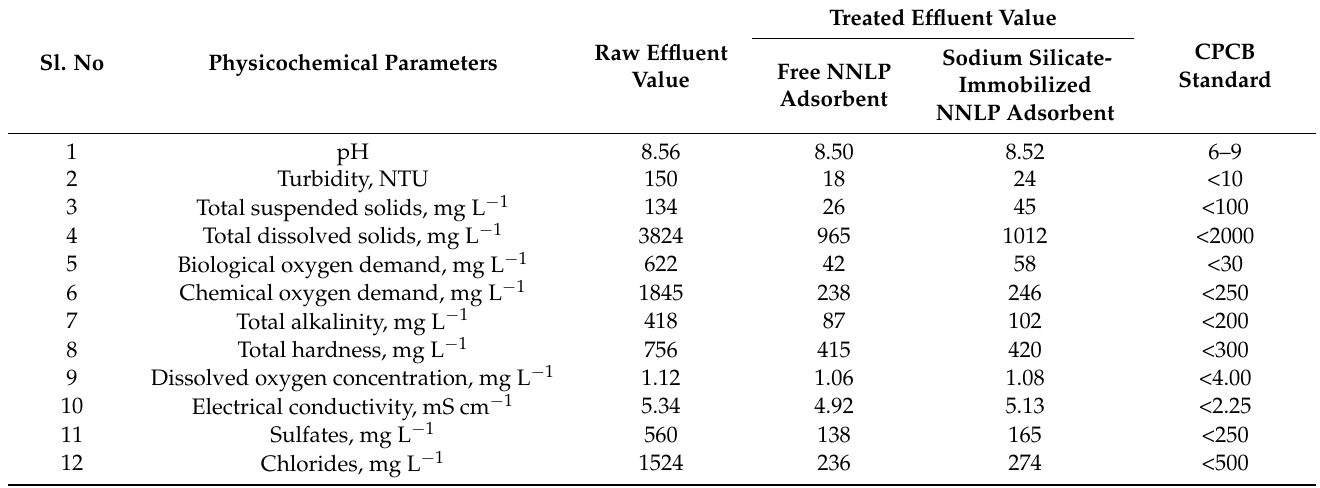
Table 6. Characteristics of real and treated textile industrial CR dye effluent with CPCB acceptable limits.